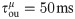
Effect of adaptation current timescale on reproduction accuracy.Performance measures and population spike rate statistics (cf. Fig 2A and 2B) as a function of the adaptation time constant τw, that takes values between 20 ms (equal to the membrane time constant) and 200 ms (used throughout the rest of the study). The spike-triggered adaptation increment b was co-varied (antiproportional to τw) such that the product τw
b = 8 pAs is fixed for all shown parametrizations. The input mean μext(t) fluctuates with timescale τouμ=50ms and strength ϑμ = 0.54 mV/ms (same value as for examples in Fig 2C) around a smaller (A) and a larger (B) baseline mean μ¯, while the input deviation σext is constant. Note that the rightmost parametrization of A corresponds to Fig 2C (top example) and is contained in Fig 2A (bottom right) while that of B is shown in Fig 2A (bottom left).